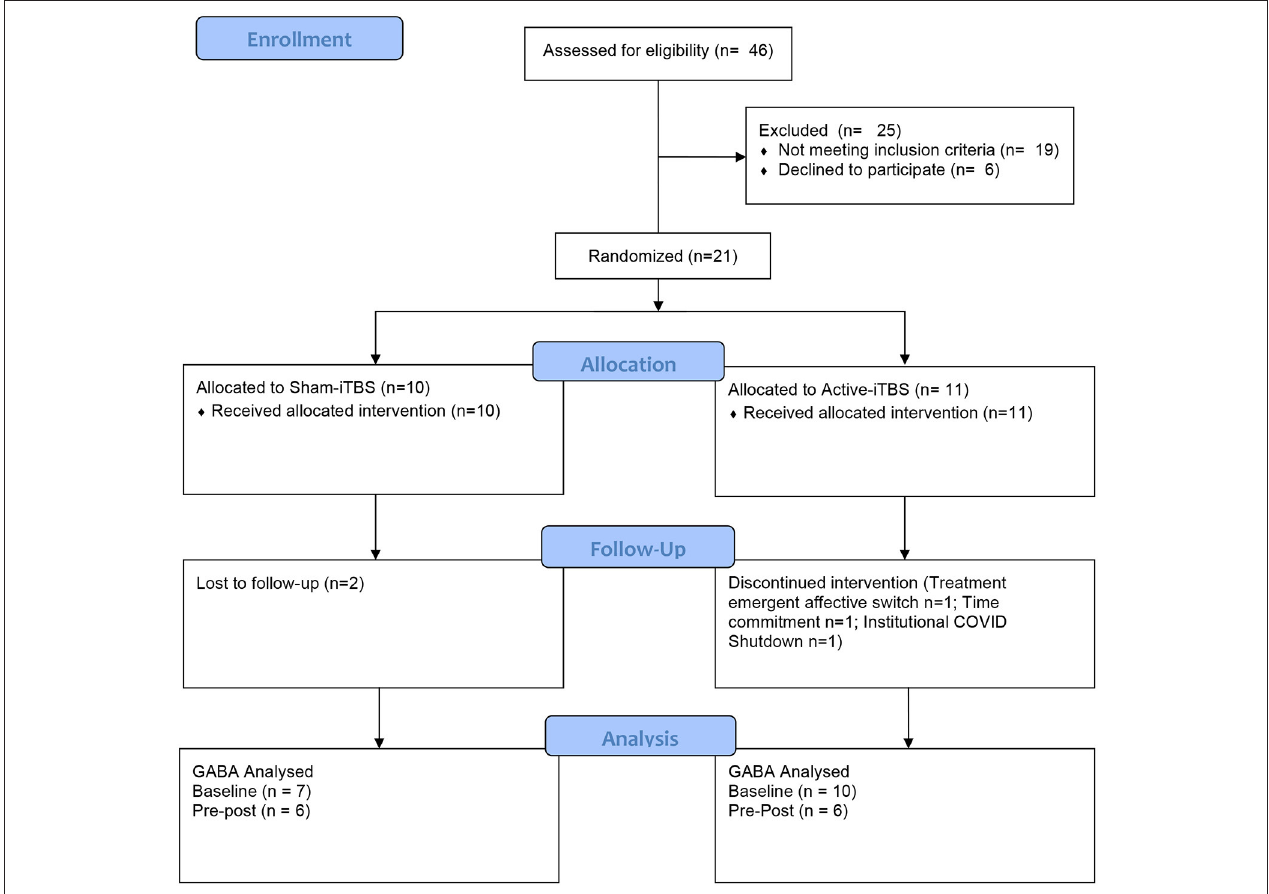
FIGURE 2 | CONSORT flow